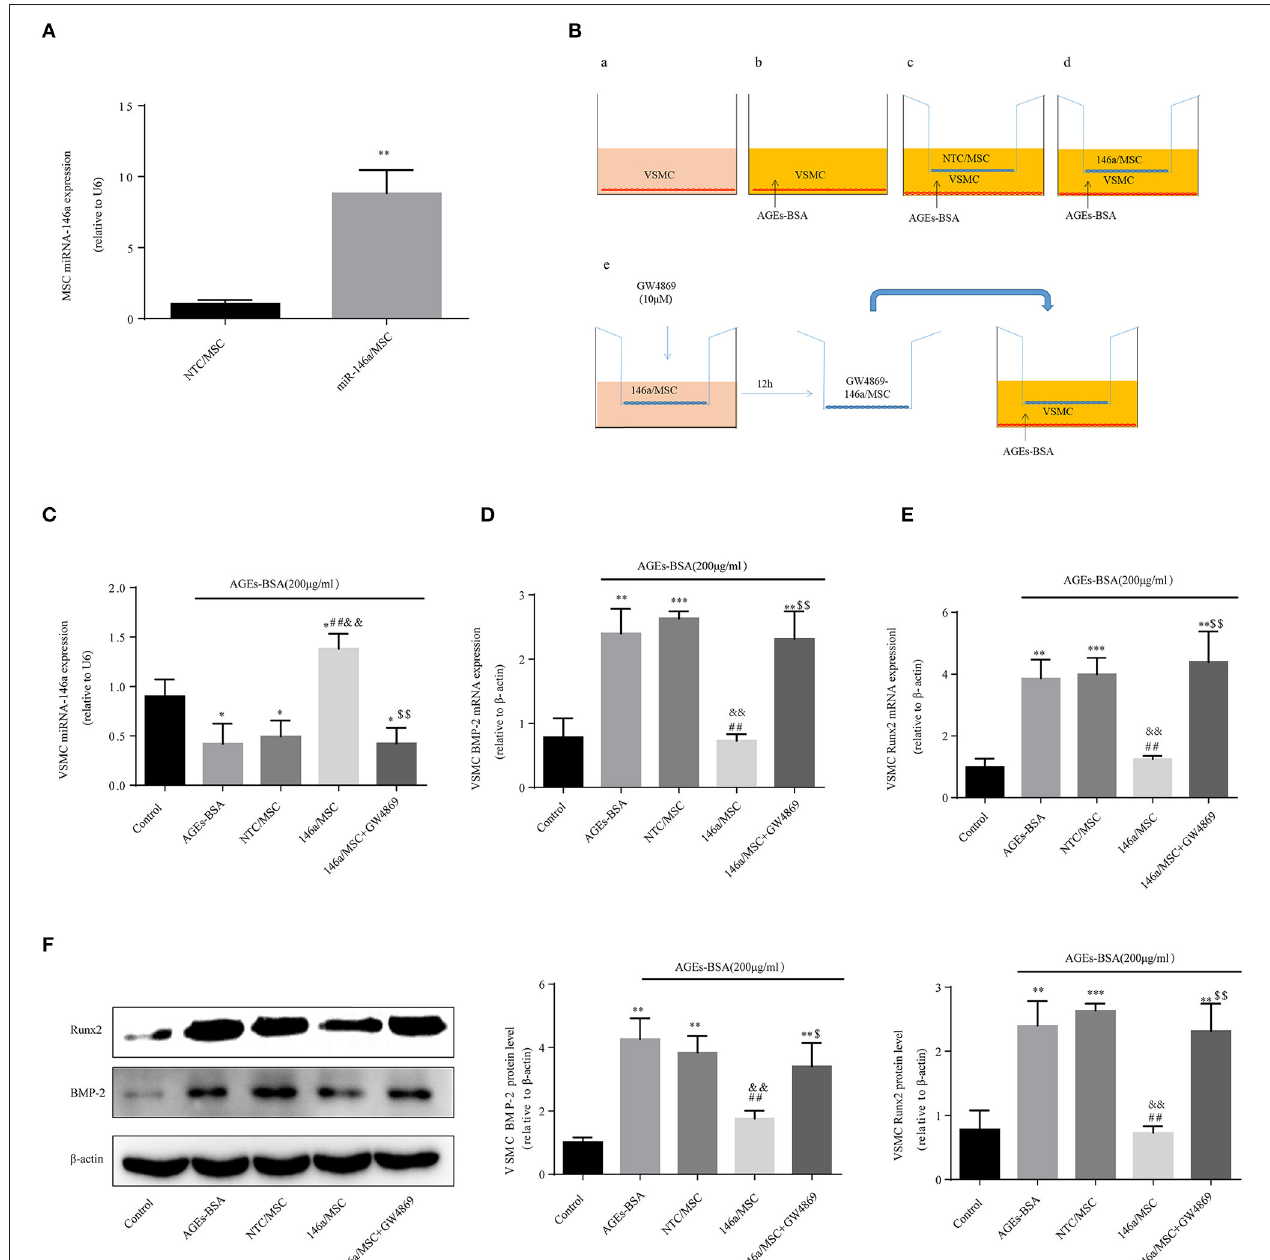
FIGURE 6 | MSC-derived miR-146a-containing exosomes inhibit the osteogenic differentiation of VSMCs. (A) MSCs were transfected with a miR-146a-expressing plasmid, and the transfection efficiency was determined by qPCR. ** p < 0.015 vs. NTC/MSC group. (B) The Transwell system. (C) miR-146a expression determined by qPCR. * p < 0.05 vs. the control group; ## p < 0.01 vs. AGEs-BSA group; && p < 0.01 vs. AGEs-BSA + NTC/MSC group; and $$ p < 0.01 vs. AGEs-BSA + 146a/MSC group. (D,E) Runx2 and BMP-2 mRNA levels were determined by qPCR. (F) Runx2 and BMP-2 protein levels determined by Western blotting. * p < 0.05, ** p < 0.01, and *** p < 0.001 vs . the control group; ## p < 0.01 vs. AGEs-BSA group; && p < 0.01 vs. AGEs-BSA + NTC/MSC group; $$ p < 0.01 vs. AGEs-BSA + 146a/MSC group.